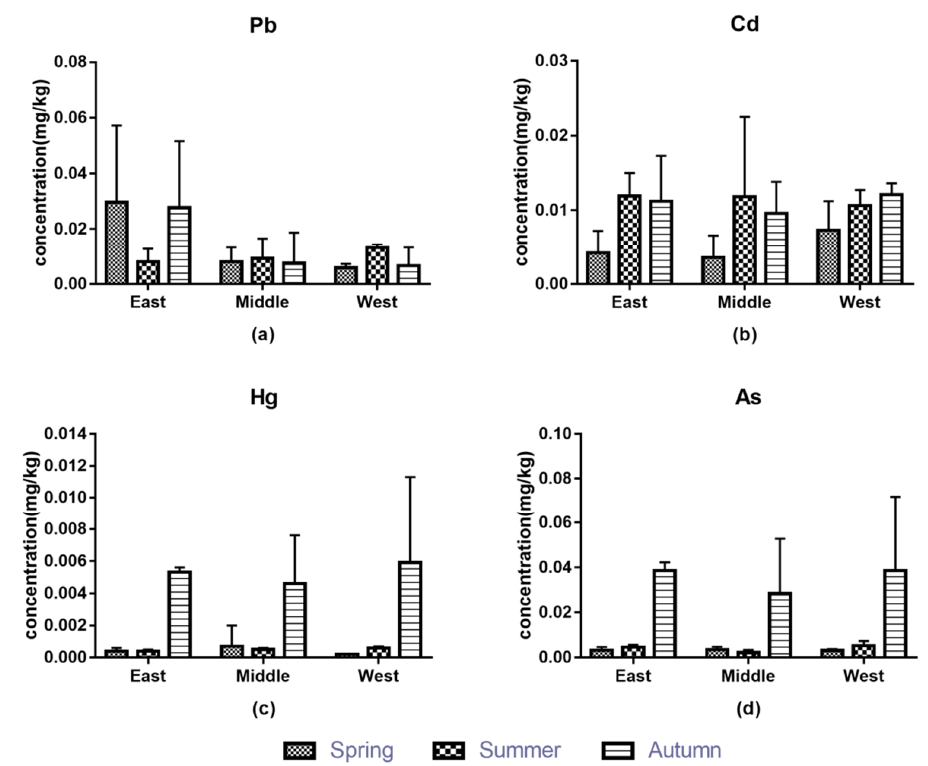
Figure 2. The contents of metals in asparagus: ( a ) Pb, ( b ) Cd, ( c ) Hg, ( d ) As. The mean values of Pb and As (20.2520 mg/L for Pb and 7.9159 mg/L for As) in soil were lower than the Shanghai soil background values that were used as a reference system, while the mean values of Cd and Hg (0.1954 mg/L for Cd and 0.1263 mg/L for Hg) were higher than the background values [48]. In Figure 3, the contents of four elements in soil showed similar rules in three sampling seasons: Pb > As > Cd > Hg. In the three harvest seasons, the highest cadmium content was found in the west, which may have been due to a higher background value than that in the eastern and central regions. In the three regions, the highest contents of lead and arsenic were in spring, and the change of arsenic content was spring > autumn > summer; cadmium content in spring was highest in the central and western regions, and the east region was summer. Mercury content in autumn was the highest in the east and west, and for the middle region was spring. Comprehensive analysis of metal contents in soil in different regions showed that lead and cadmium contents were highest (22.1828 mg/kg and 0.2210 mg/kg, respectively) in the western region, mercury content was highest (0.1549 mg/kg) in the eastern region, and arsenic content was highest (8.0947 mg/kg) in the central region. Spring was the